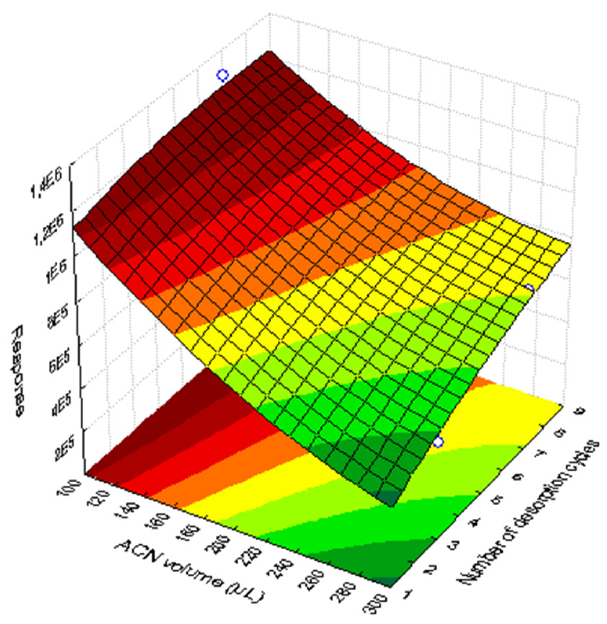
Figure 4. Response surface obtained from a Doehlert design employing volume of ACN and number of desorption cycles. Extraction was performed with 20 mg of Si3Py + Cl − ; 100 µ g L − 1 of each analyte; six extraction cycles with 700 µ L of sample in each cycle and 15 s of extraction time; and five desorption cycles with 100 µ L of ACN and 15 s of desorption time.